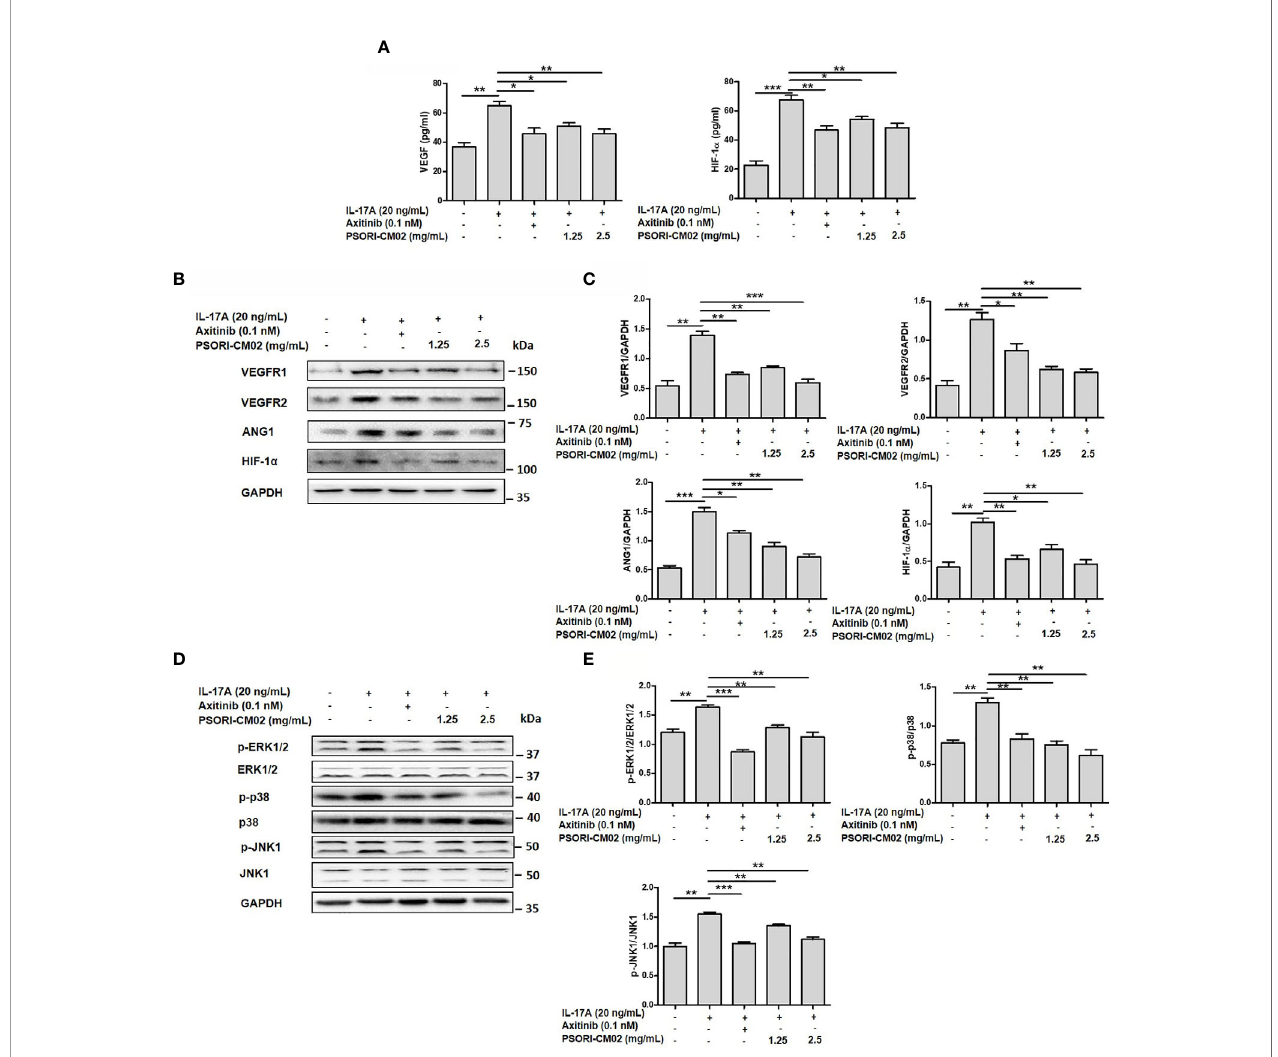
FIGURE 3 | PSORI-CM02 suppressed the expression of pro-angiogenic factors and the phosphorylation of MAPK signalling pathway components in interleukin (IL)- 17A-stimulated human umbilical vein endothelial cells (HUVECs). (A) HUVECs were treated with 1.25 or 2.5 mg/mL PSORI-CM02 for 24 h and then stimulated with 20 ng/mL IL-17A for 6 h. The levels of hypoxia inhibitory factor (HIF)-1 a and vascular endothelial growth factor (VEGF) were determined by ELISA. (B) Representative western blots of VEGF receptor 1 (VEGFR1), VEGFR2, angiopoietin 1 (ANG1), and HIF-1 a expression in HUVECs treated with 1.25 and 2.5 mg/mL PSORI-CM02 or 0.1 nM axitinib for 24 h and then stimulated with 20 ng/mL IL-17A for 6 h. (C) Quanti fi cation of VEGFR1 , VEGFR2 , ANG1 , and HIF-1 a levels relative to GAPDH levels at 24 h. (D) Representative western blot of MAPK pathway protein expression in HUVECs treated with 1.25 and 2.5 mg/mL PSORI-CM02 or 0.1 nM axitinib for 24 h and then stimulated with 20 ng/mL IL-17A for 6 h. (E) Quanti fi cation of phospho-ERK1/2, phospho-p38, and phospho-JNK1 relative to ERK1/2, p38, and JNK1 at 24 h. Data represent the mean ± SEM of at least three independent experiments (* p < 0.05, ** p < 0.01, *** p < 0.001 vs. the IL-17A- stimulated HUVEC